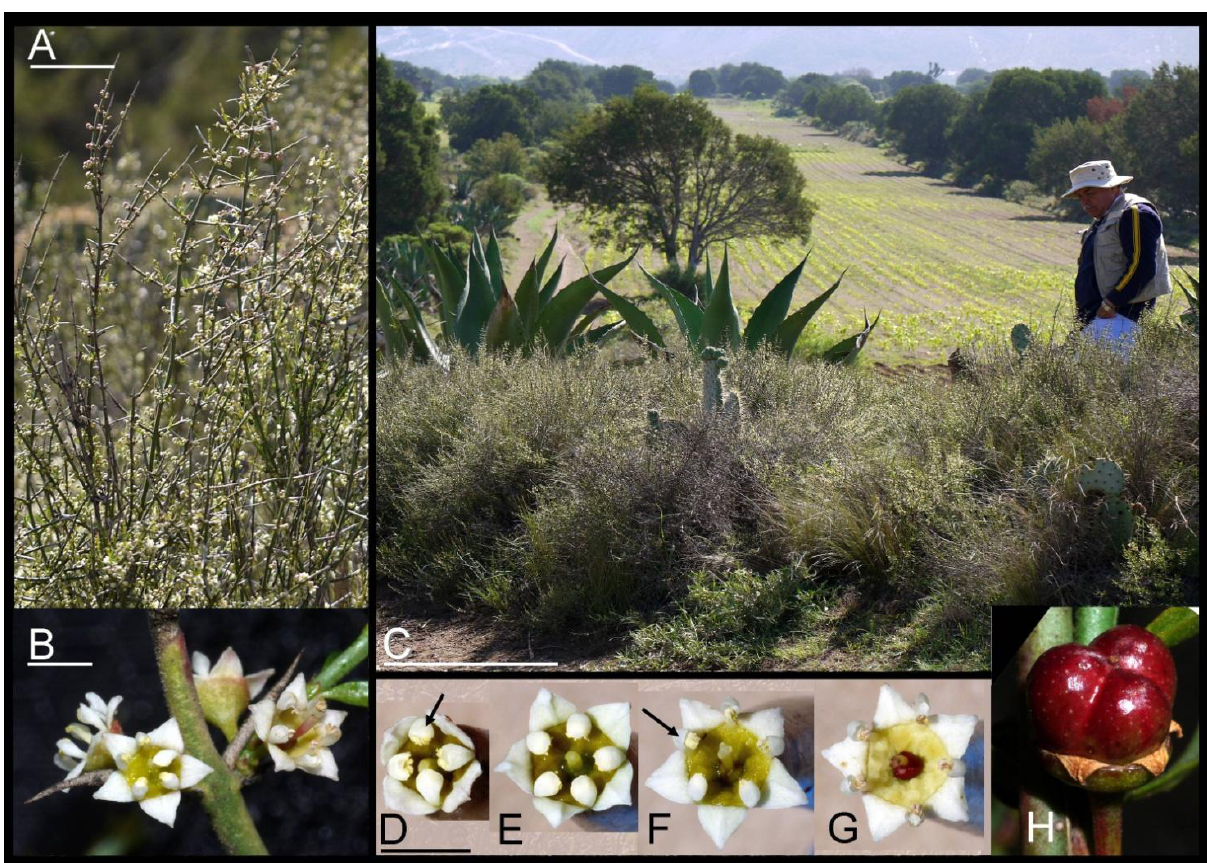
F IGURE 1. Adolphia infesta. (A) habit, (B) a flowering node displaying mid- and late-anthesis flowers, (C) a patch consisting of several individuals, with cultivated plots and uncultivated windbreaks at the background, (D to H) flowers in anthesis stages 2, 3, 4, and 5 (D to G; note that stage 2 is represented by a 4-merous flower) and a developing fruit (H). Arrows in (D) and (F) indicate petals. Bar = 15 cm (A), 2 mm (B), 1 m (C) and 2 mm (D, also valid for E-H). Photos by D.